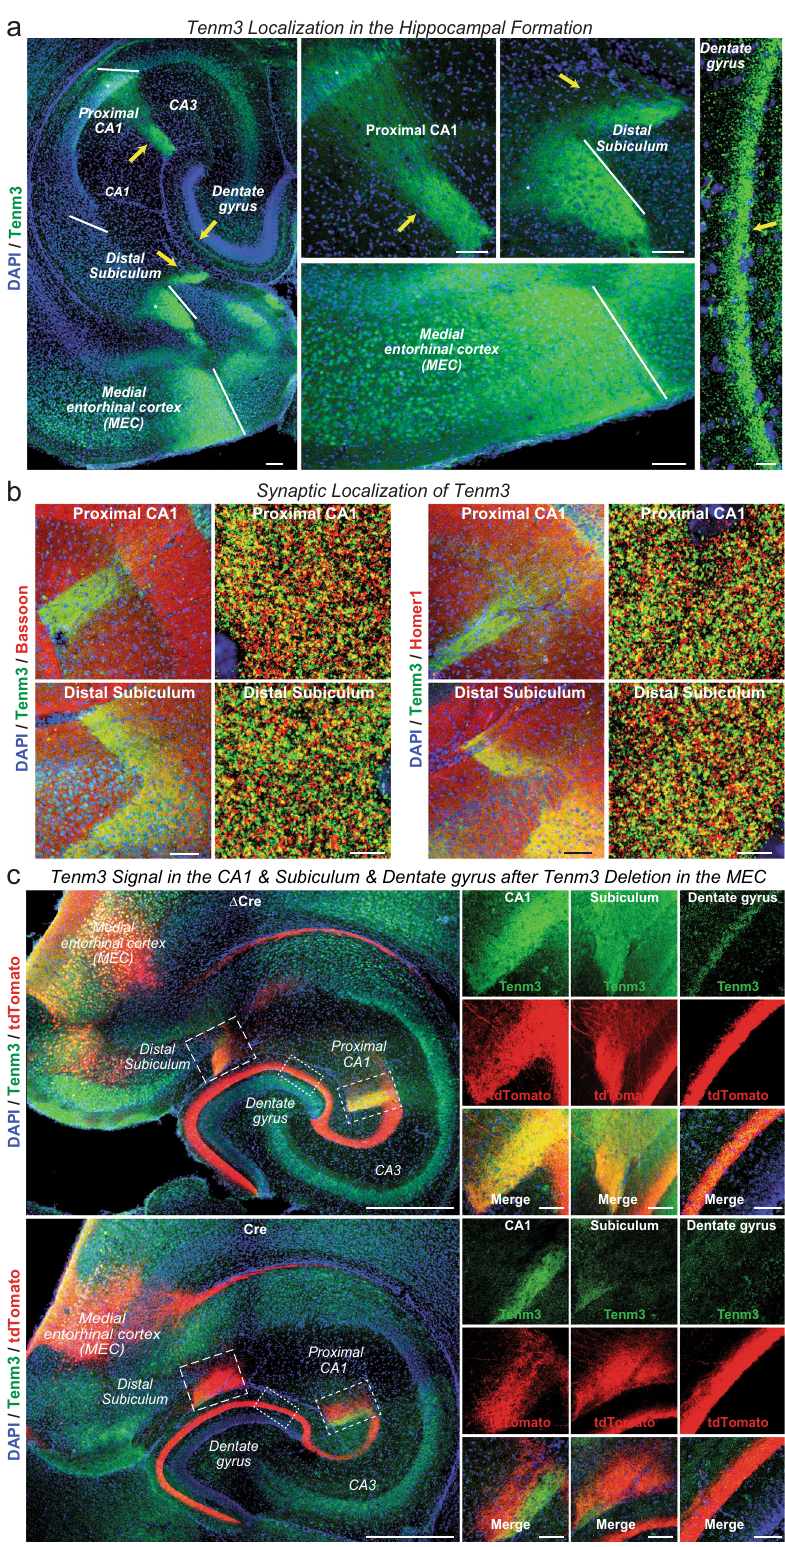
of the hippocampus are enriched in synapses. The S. lacunosum- moleculare of the CA1 and the molecular layer of the subiculum are the sites of dense input synapses derived from MEC neurons 37 – 40 . Double-labeling of hippocampal sections for Tenm3 and for markers of all presynaptic terminals (Bassoon), of excitatory (vGluT1) or of inhibitory presynaptic